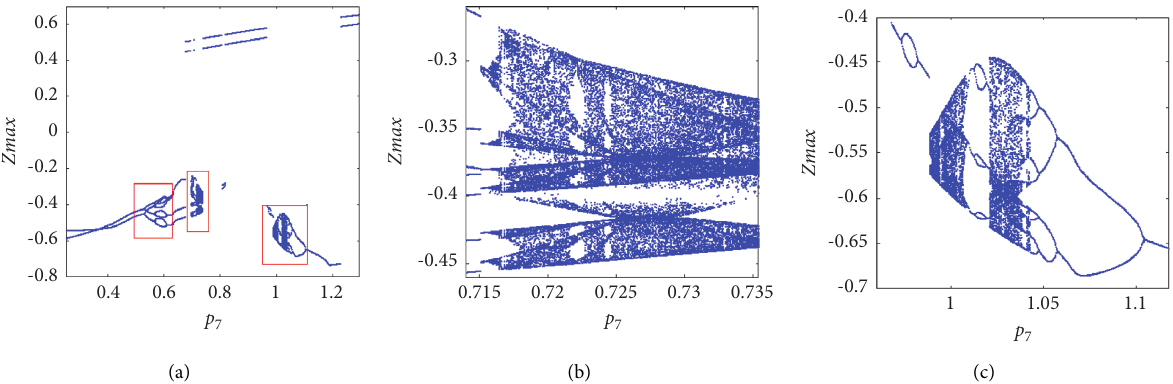
Figure 4: (a) Bifurcation diagram of the system with ( p − 1, − 1). A magnified version of the bifurcation diagram versus (b) p